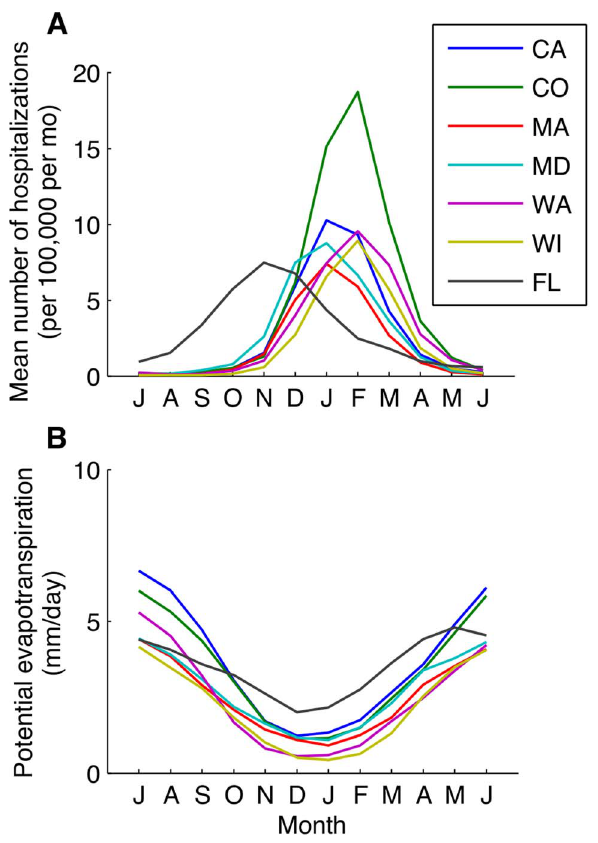
Fig. 4. Monthly patterns of RSV activity and potential evapotranspiration. ( A ) The mean number of RSV hospitalizations per 100,000 total population per month for select states, beginning in July. ( B ) The monthly mean potential evapotranspiration (mm/day) is plotted for each state.